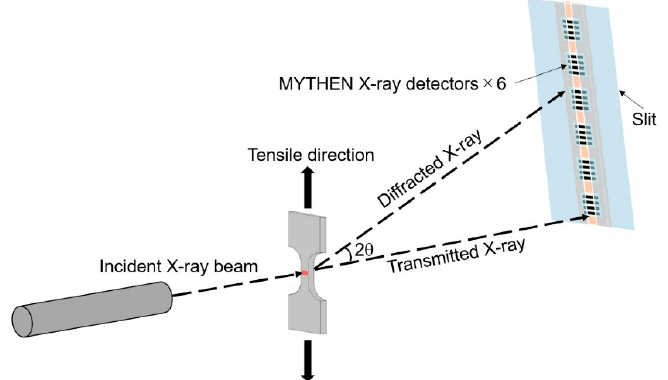
Figure 1. Schematic illustration of the in situ X-ray diffraction (XRD) measurement system in SPring-8.